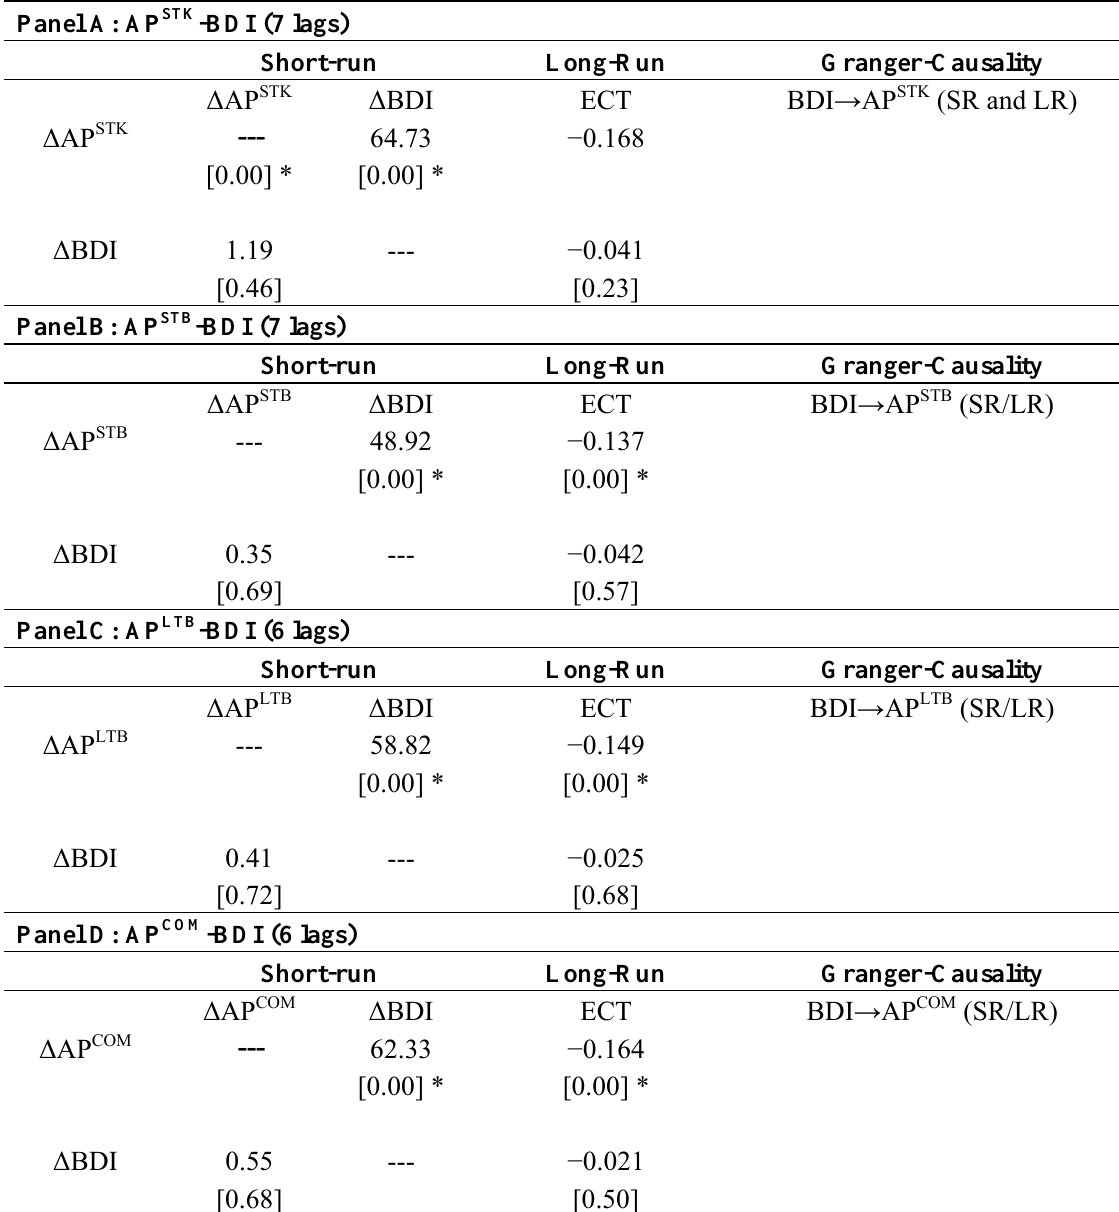
Table 4. Panel causality test